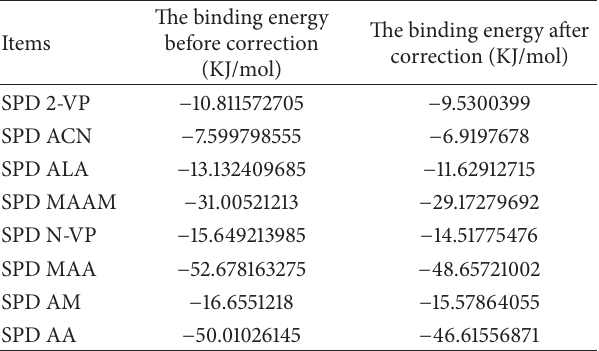
Table 1: The binding energy for the interaction between template molecule and the functional monomer in the ratio of 1